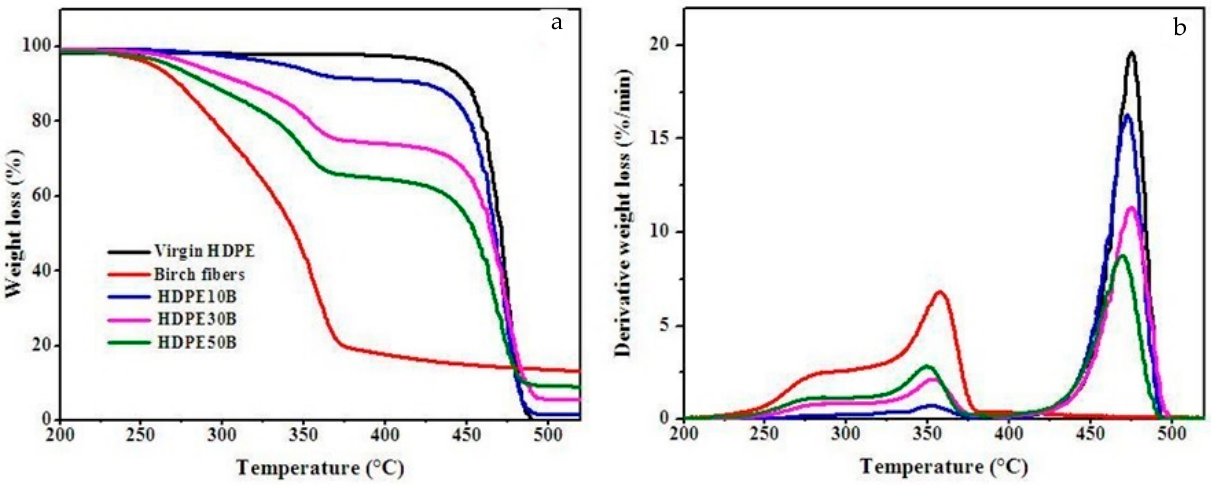
Figure 5. ( a ) Thermogravimetric curves and ( b ) first-derivative analysis of the thermal breakdown of virgin HDPE, birch fiber and HDPE/fiber composites.